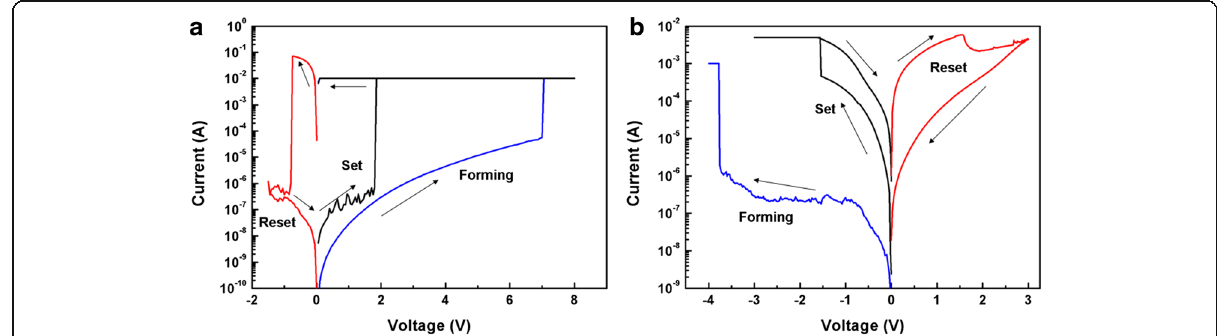
Fig. 2 The typical bipolar resistive switching characteristics of the RRAM devices. a Pt/HfO 2 /TiO 2 /HfO 2 /Pt. b Pt/HfO 2 /TiO 2 /HfO 2